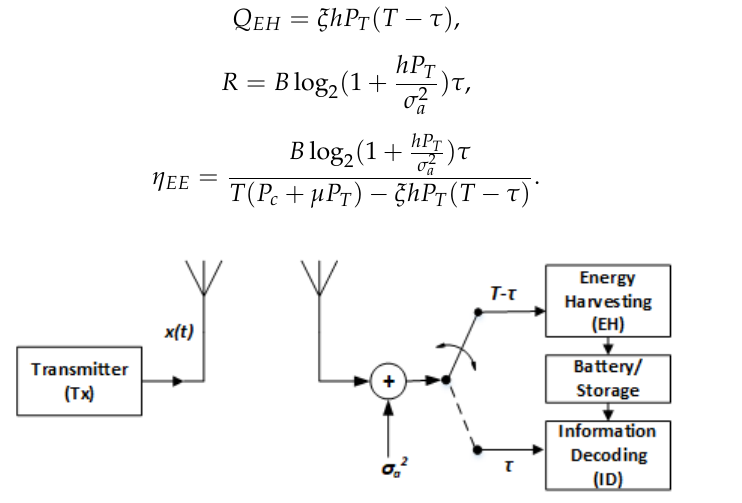
Figure 3. SWIPT time switching (TS)